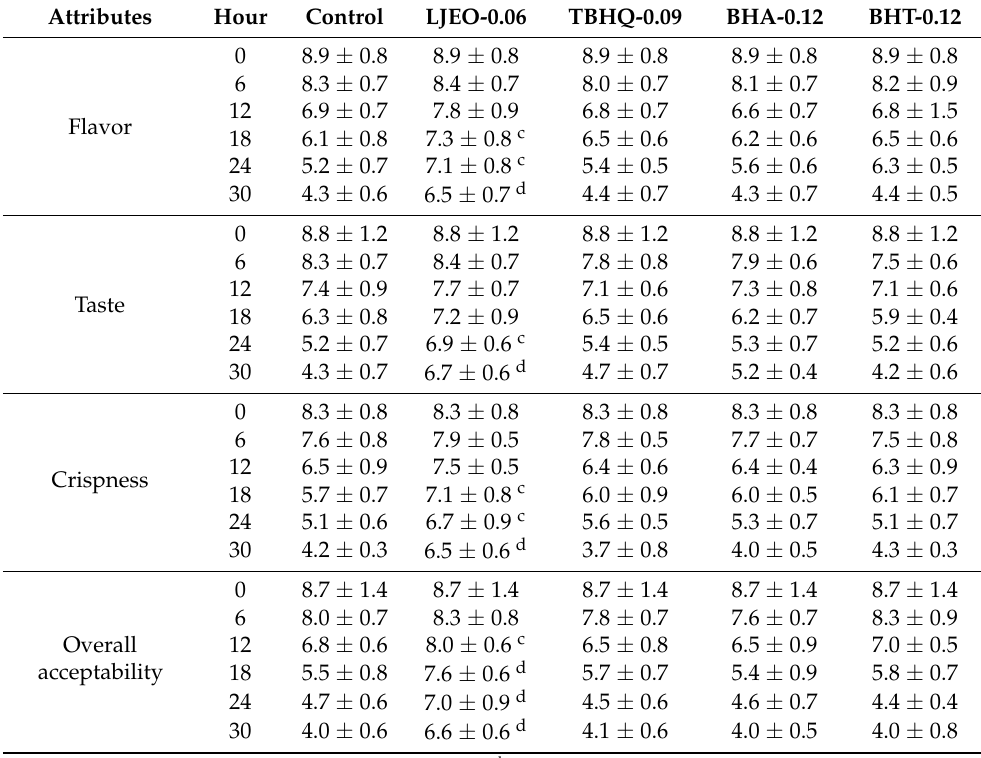
Table 3. The influence of the essential oil from the flower buds of L. japonica on the sensory properties of Youmotou , such as flavor, taste, crispness, and overall